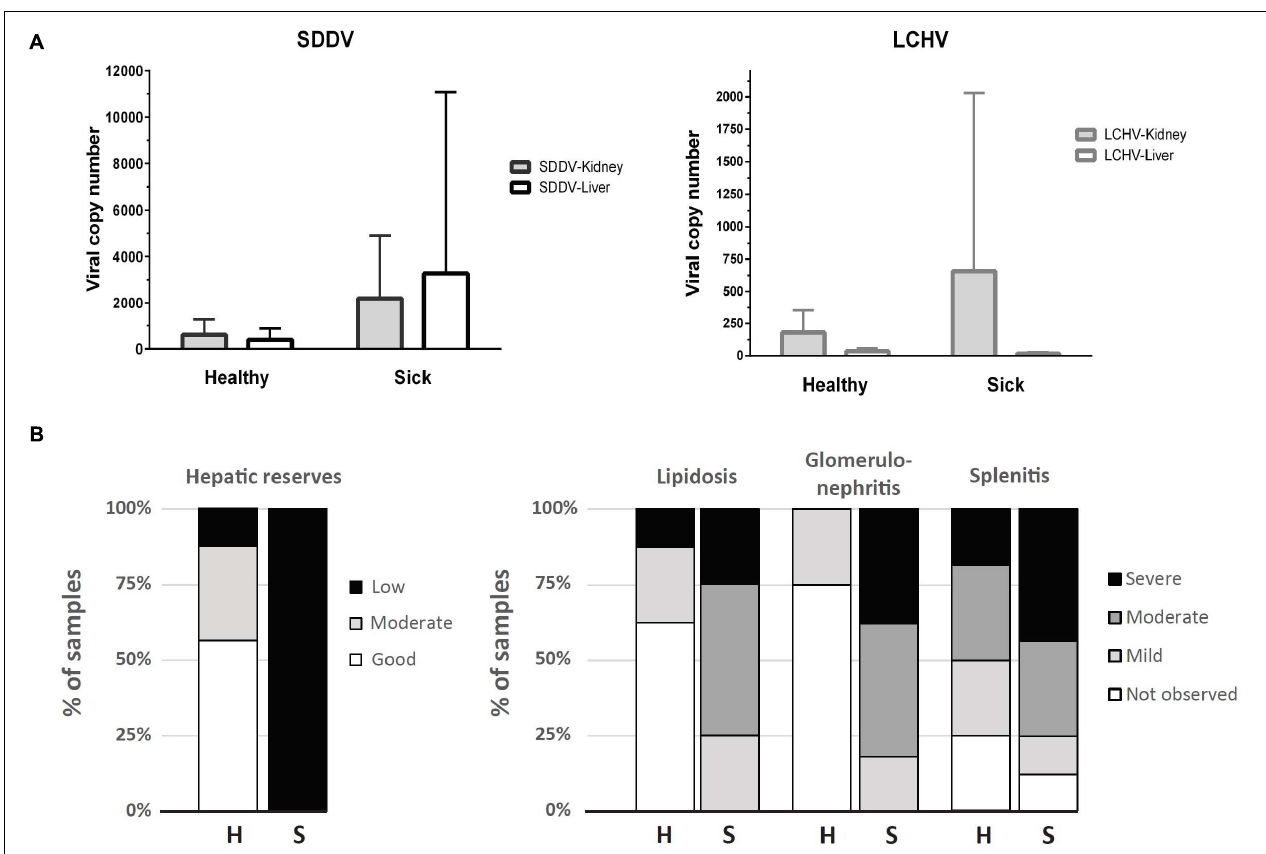
FIGURE 1 | (A) Viral copy number (mean + SD) determined by qPCR assays for SDDV and LCHV of samples derived from kidney and liver ( n = 8, except for liver of the sick fish, where n = 7). (B) Distribution of samples according to histopathology scores of liver (hepatic reserves and lipidosis), spleen (splenitis), and kidney (glomerulonephritis) of apparently healthy (H, n = 8) and sick (S, n = 8)